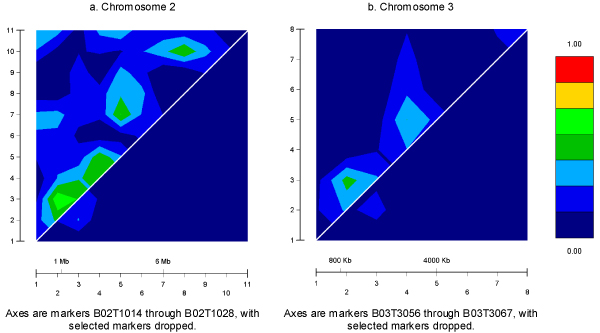
Pairwise disequilibrium coefficients: simulated LD reduced. |D'| above and r2 below diagonal